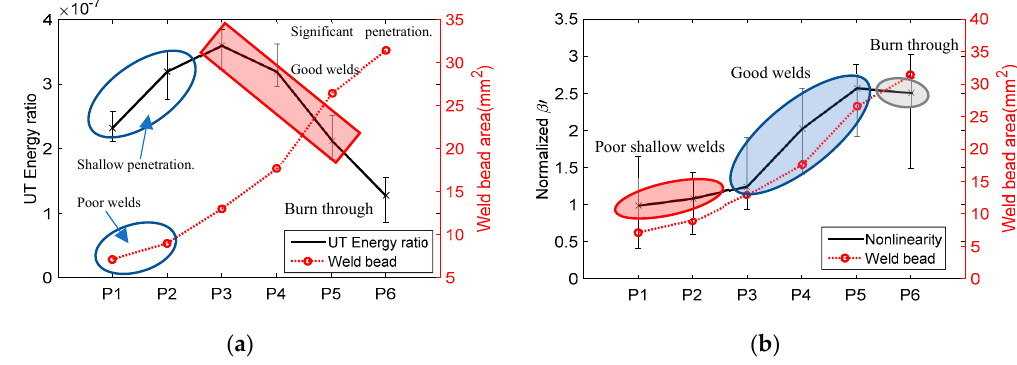
Figure 8. The correlation of weld bead area with ( a ) LUT energy ratio and ( b ) normalized nonlinearity coefficient.